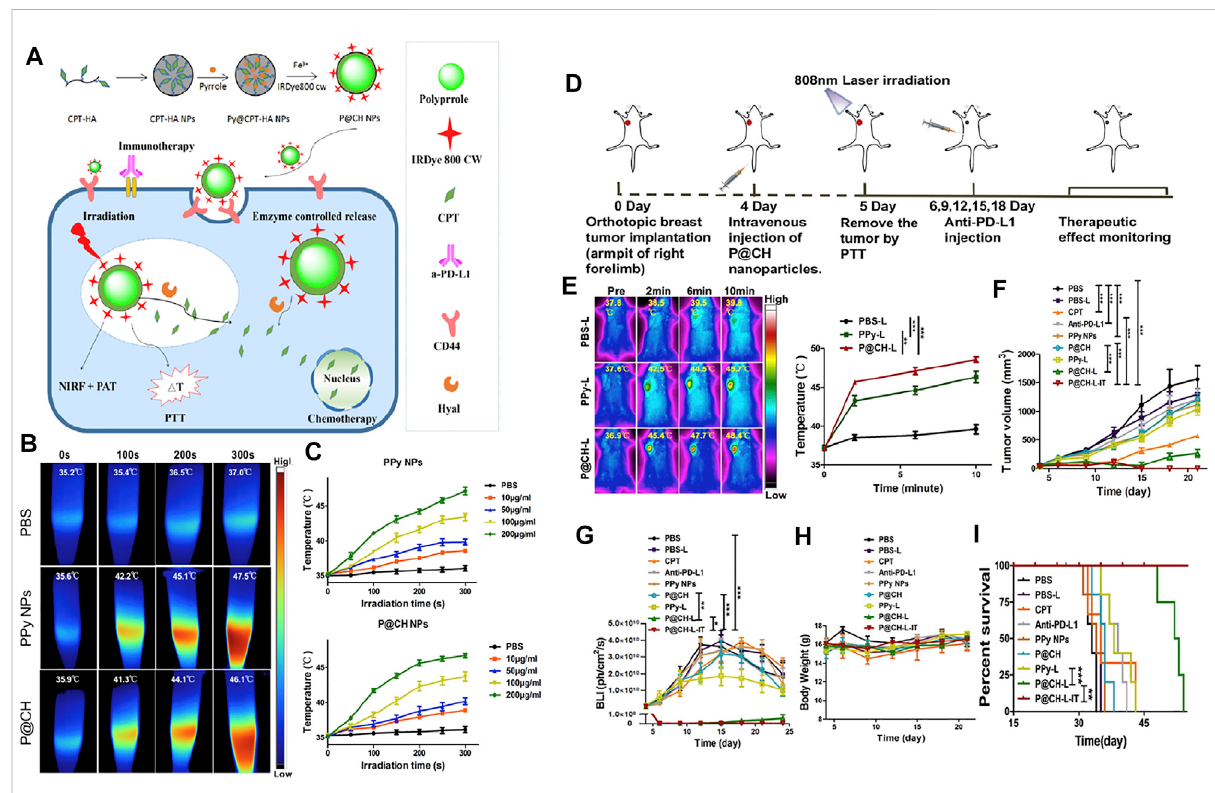
FIGURE 5 (A) Schematic illustration of the formation and functions of P@CH nanoparticles. (B) NIR thermal imaging before and after NIR irradiation on PBS, PPy NPs, and P@CH NPs plus laser irradiation. (C) Monitoring the increase of temperature with prolonged irradiation time over a series of concentrations of PPy NPs, and P@CH NPs ( n = 3). (D) Scheme showing the experimental design to evaluate the therapeutic effect. (E) Infrared thermalimagesofthetumor-bearingmiceat24 hpost-injectionofPBS,PPyNPs,andP@CHNPs via thetailvein,beforeandafterNIRlaserlight irradiation (1.5 W/cm2, 10 min), and the increase of temperature at tumor sites at different time points. (F) Tumor volume measurement for different treatment groups. (G) Quanti fi cation of the BLI signal of tumors after different treatments. (H) The body weight of 4T1 tumor-bearing mice with different treatments was measured. (I) Survival analysis of orthotopic 4T1 breast cancer mice with different treatments ( n = 5) (** p < 0.01). Immune- memory effects induced by P@CH-L-IT combination treatment. Reproduced with permission from ref (Chen et al., 2019). CC BY 4.0.